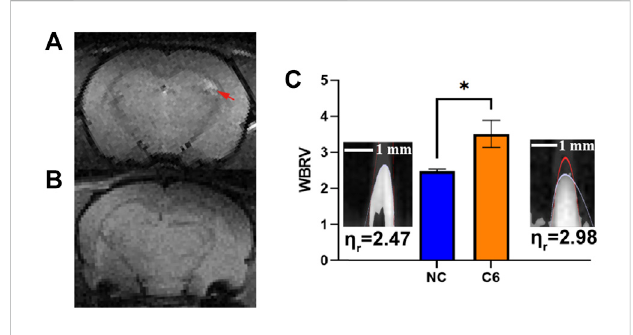
FIGURE 5 T 2 WI for the brain in C6 rat (A) and NC rat (B) . The rats ’ WBRV (measured in the left common carotid artery by LSDI) of NC and C6 groups (C) , *: p <